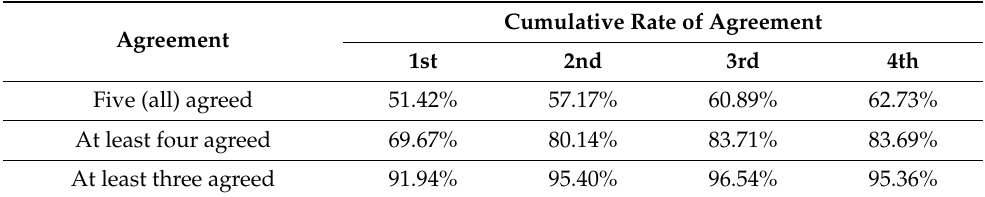
Table 5. Inter-transcriber agreement in tagging prosodic break alone.